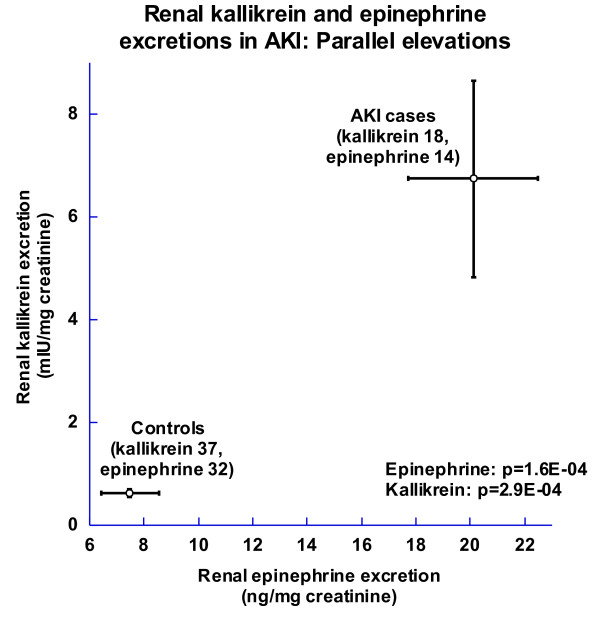
Coordinate effects of AKI on kallikrein and epinephrine excretion. Results (shown as mean ± 1 SEM) were analyzed by one-way ANOVA, factoring for age, sex and race. The numbers studied for kallikrein are 18 established AKI patients and 37 healthy controls. The numbers studied for epinephrine are 14 established AKI patients and 32 healthy controls.